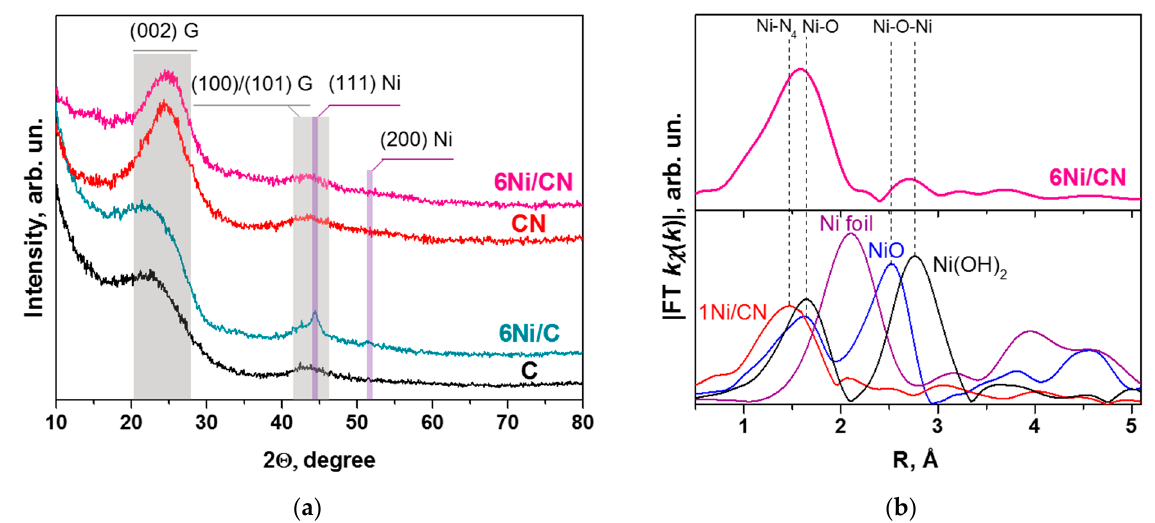
Figure 3. ( a ) XRD patterns of N-free (C) and N-doped (CN) supports and 6Ni/C and 6Ni/CN nanomaterials after the catalytic reaction. G denotes graphite. ( b ) The K-weighted Fourier transform spectrum of 6Ni/CN catalyst after the reaction (top panel) and spectra of 1Ni/CN, Ni foil, NiO, and Ni(OH) 2 (bottom panel) without taking into account the phase shift.